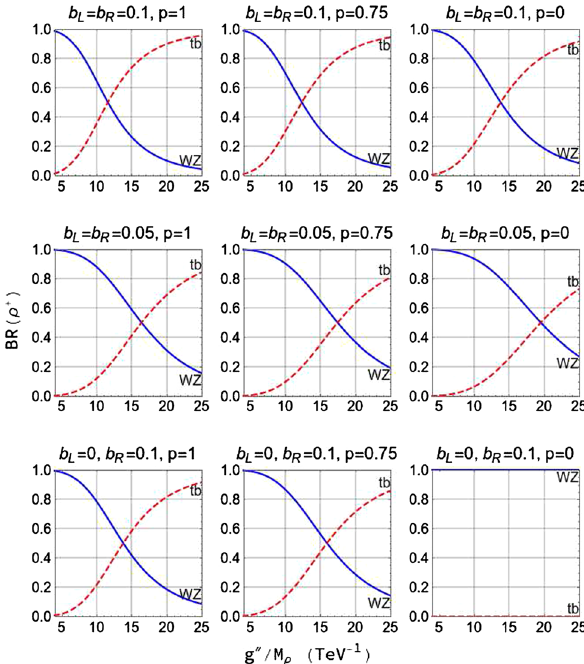
Fig. 5 The principal branching ratios of the charged vector resonance as functions of g (cid:2)(cid:2) / M ρ in the approximation of the leading order in g (cid:2)(cid:2) and x a = M a / M ρ = 0, where a = W , Z , t . The blue solid line stands for the W Z channel and the red dashed line represents the tb